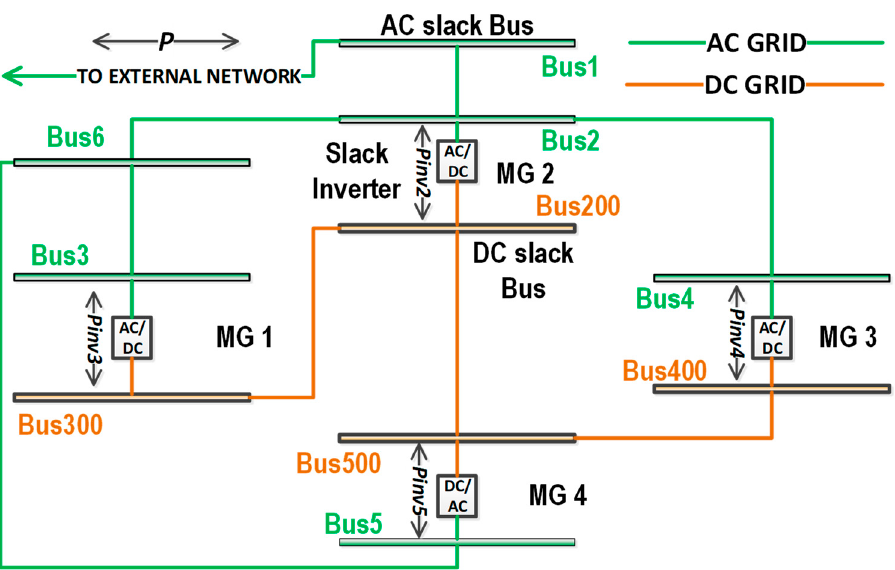
Figure 10. The hybrid AC/DC test system.